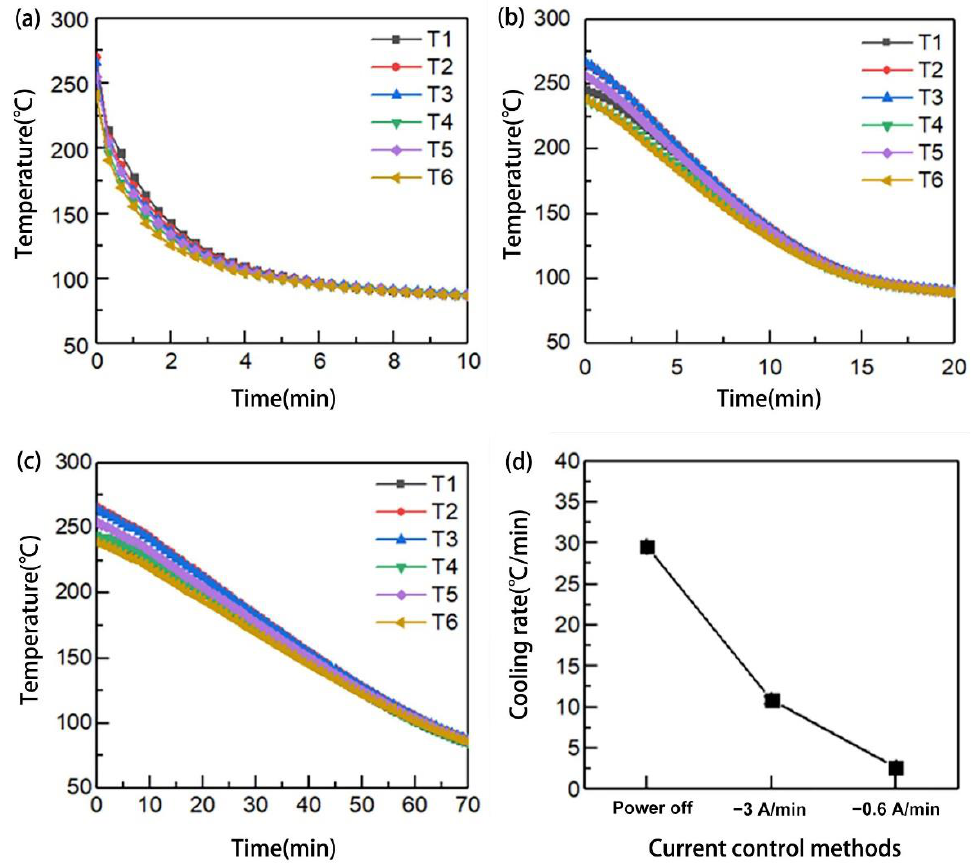
Figure 4. Currents control method and temperature changes: ( a ) temperature curve during cooling by power-off; ( b ) temperature curve during cooling by current reduction of 3 A/min; ( c ) temperature curve during cooling by current reduction of 0.6 A/min; ( d ) cooling rate under different current control methods.